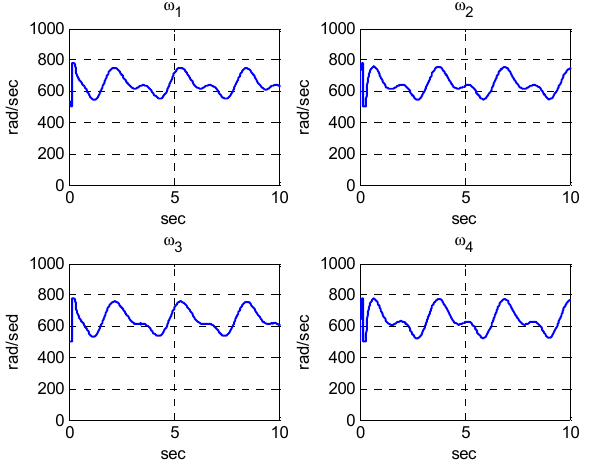
Figure 14. The rotor velocity with variable deviations and perturbations.